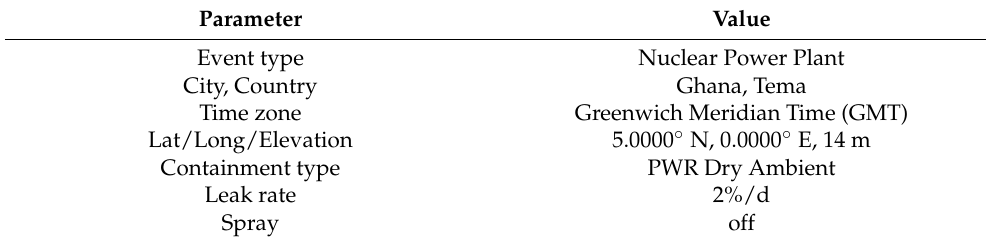
Table 4. Long-term station blackout analysis parameter using